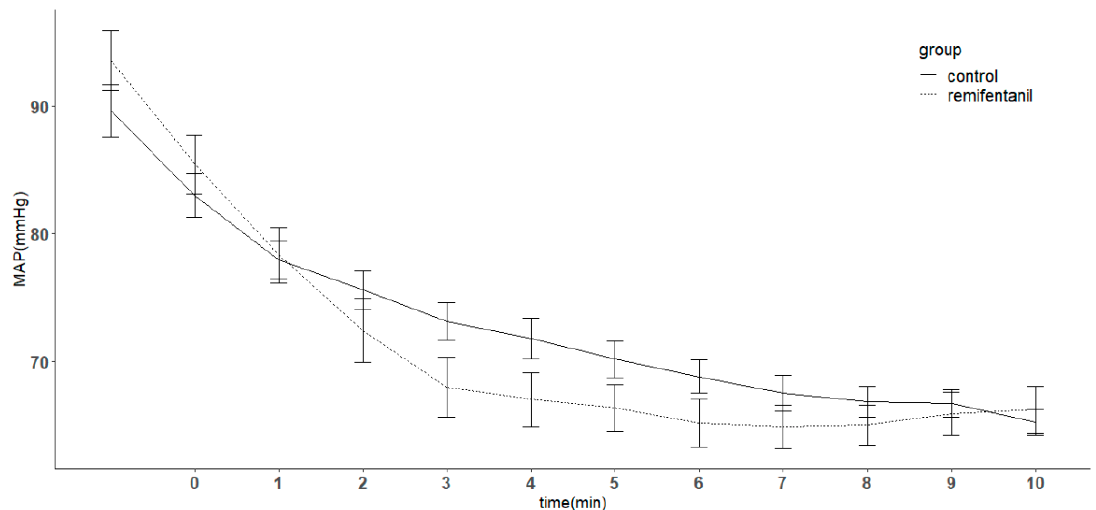
Figure 4. Changes in mean arterial pressure (MAP) in patients with or without remifentanil infusion. In unconscious patients with propofol at the target effect-site concentration of 5 μ g/mL, a remifentanil target effect-site concentration of 5 ng/mL was infused in the remifentanil group throughout the study period. The control group received normal saline instead of remifentanil. MAP decreased over time ( p < 0.05). There was no difference between the remifentanil group and control group. During the study, the two groups showed no difference at any time point. Error bar indicates standard error. In the x axis, time point 0 indicates the time the remifentanil infusion was started at an effect-site concentration of 5 ng/mL.